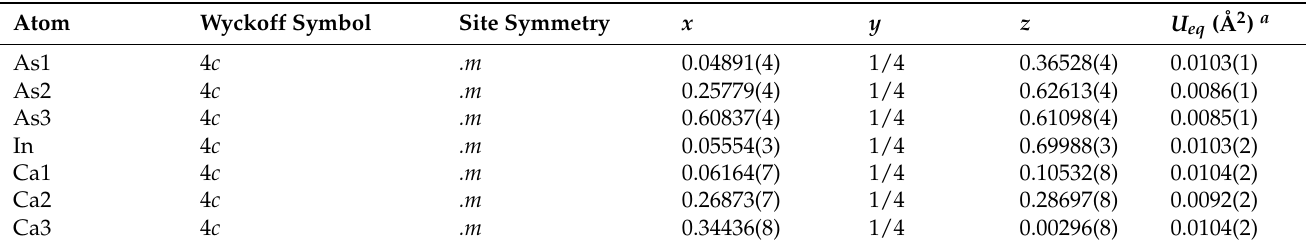
Table 2. Atomic coordinates and equivalent isotropic displacement parameters ( U eq ) for Ca 3 InAs 3